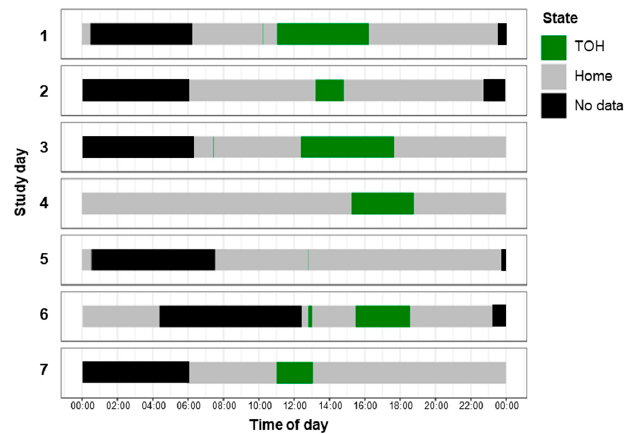
Figure 2. Temporal view of global positioning system (GPS) detected time out of home (TOH) and home events for 7 days of one participant ( Dmax = 125 m, Tmin = 6 min, Tmax = 300 min).